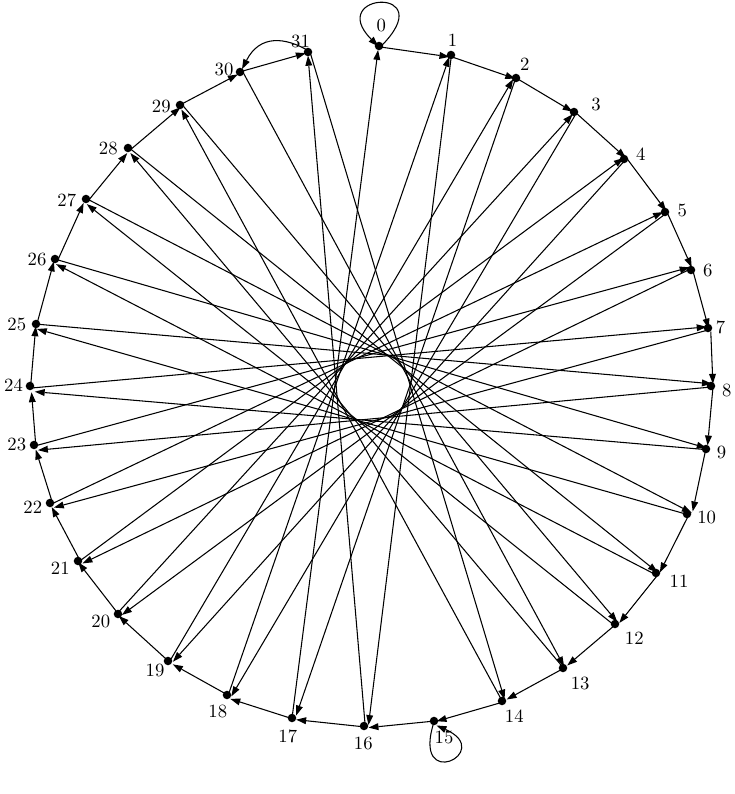
Fig. 9: A spanning 2 -diregular bieulerian subdigraph ~H 1 of ~G ′ 6